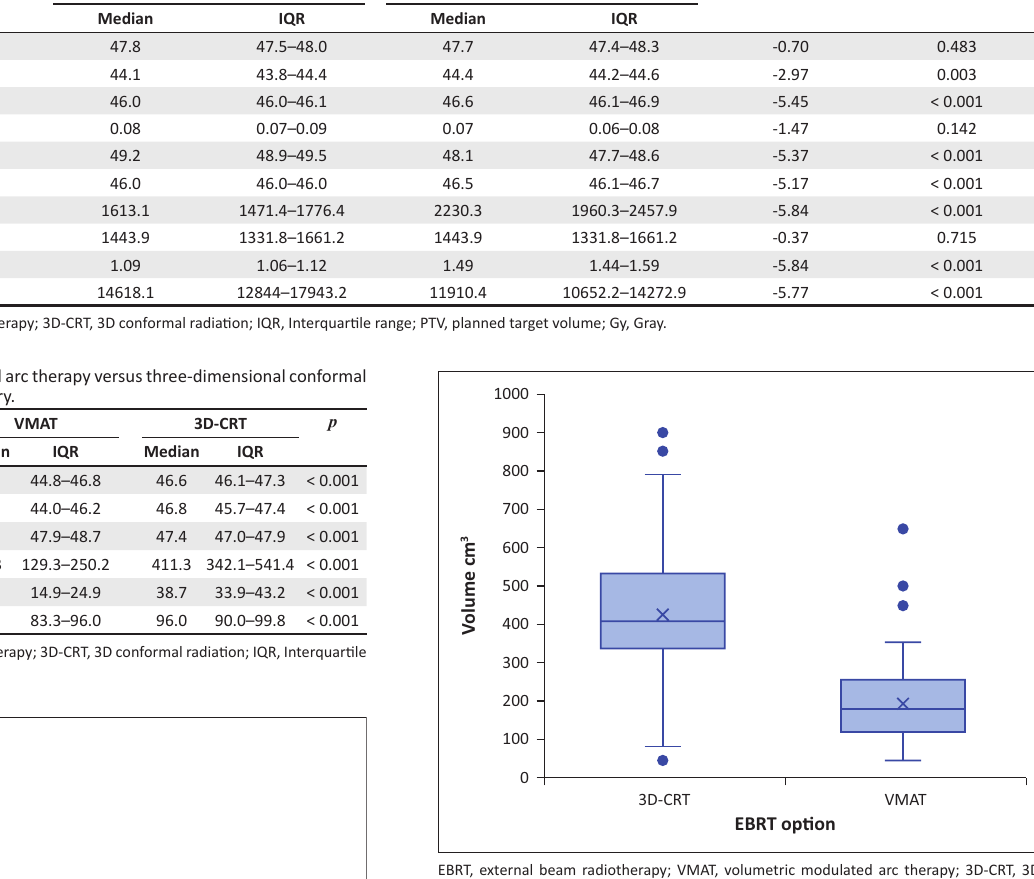
FIG URE 3: Box and whisker plot comparing bowel bag absolute volume at 45 Gy.